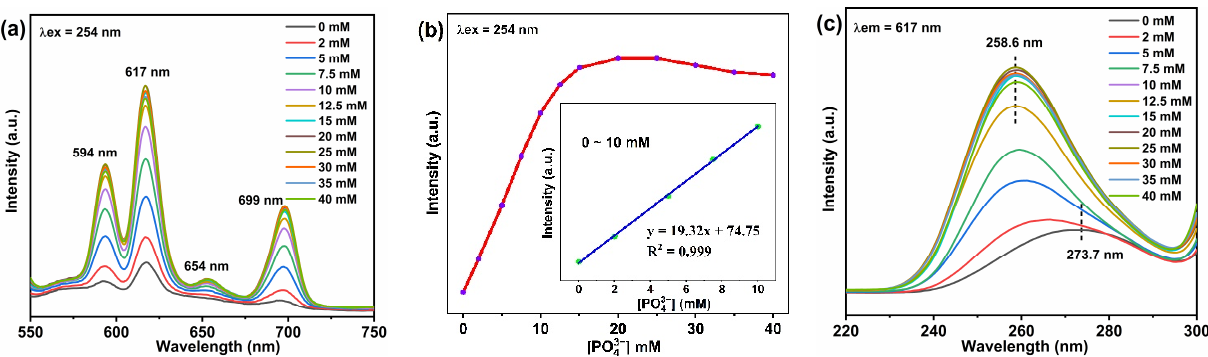
Figure 4. ( a ) Emission spectra ( λ ex = 254 nm) of PAA-Ca(Eu) nanoclusters and PO 43 − at different concentrations; ( b ) The relationship between luminescence intensity increase rate and PO 43 − concen- tration at 617 nm emission peak; ( c ) Excitation spectra ( λ em = 617 nm) of PAA-Ca(Eu) nanoclusters and PO 43 − at different concentrations.